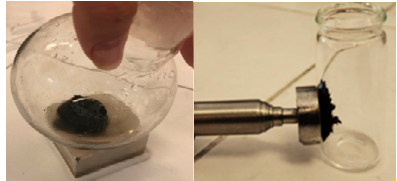
/ TiO / [FeCl κ 3 -HC(pz) 3 O 4 2 2 { 3 }] composite.